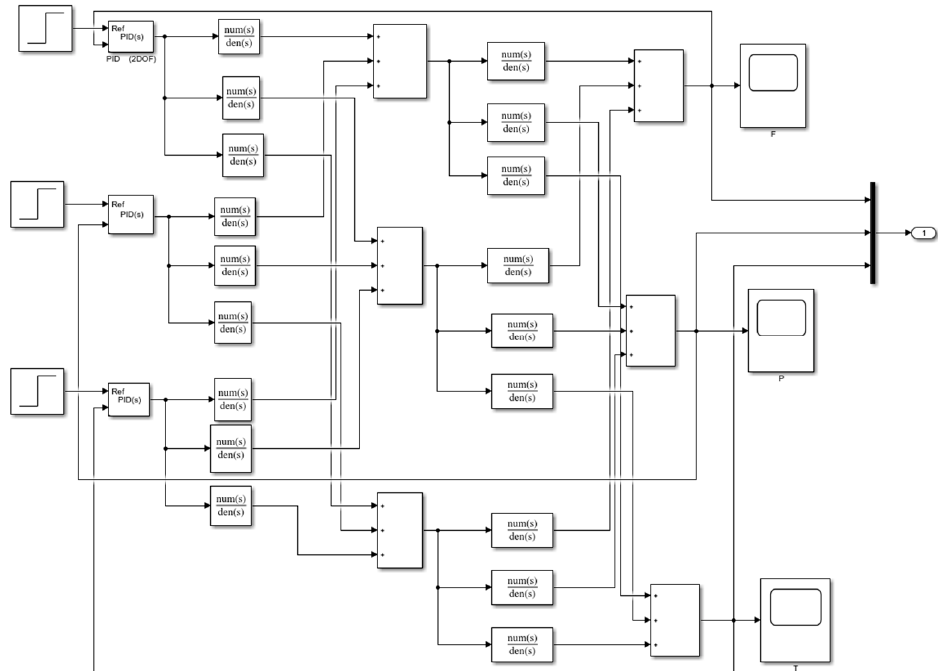
Figure 8. Simulation block diagram of gas turbine cooling system.